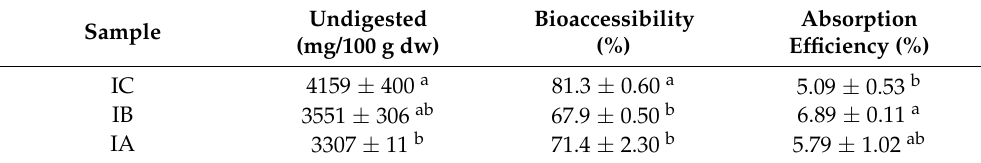
Table 2. Changes in catechin content of rosehip infusions.